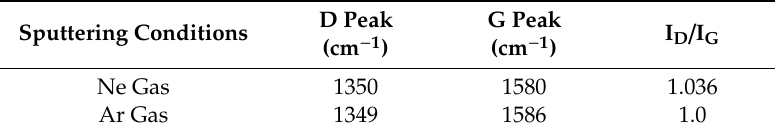
Table 2. The parameters of the C Raman spectra in a-C films.